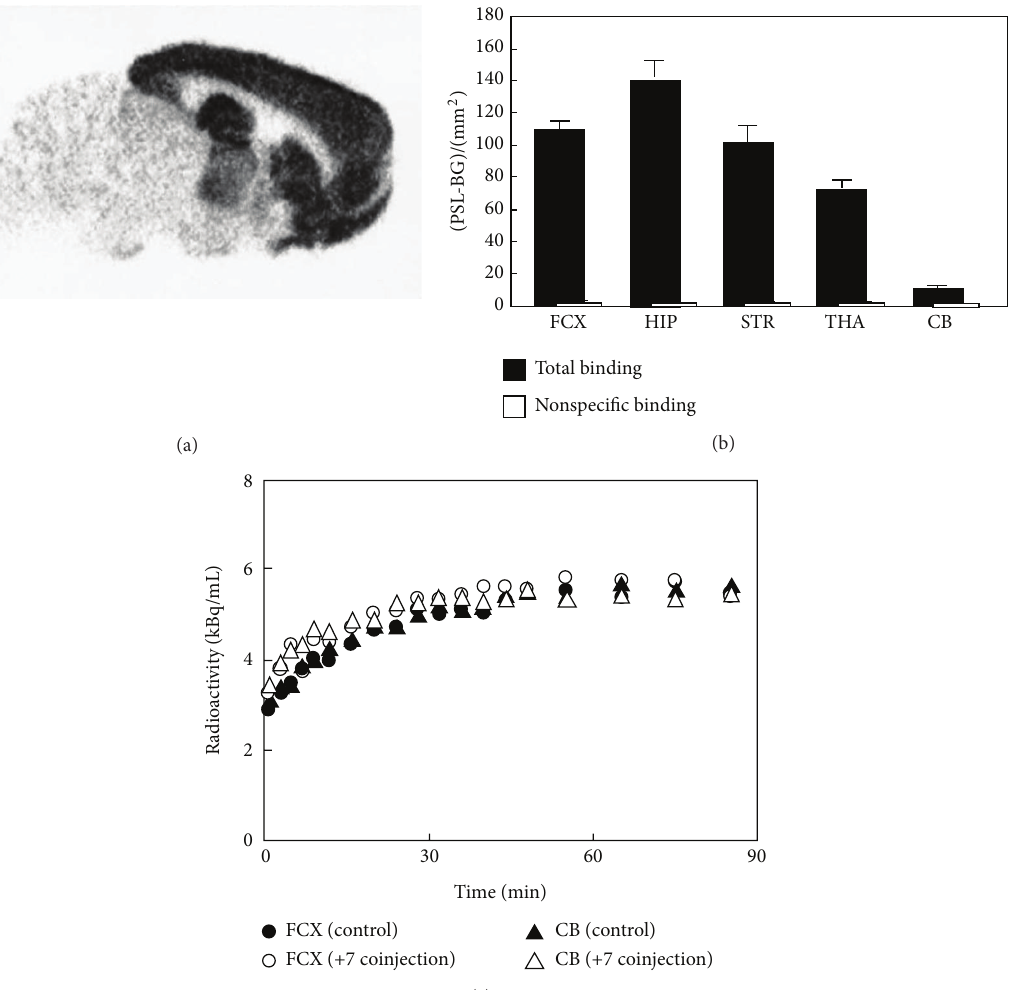
Figure 6: In vitro autoradiogram of [ 11 C] 7 (a) and quantified values of the autoradiogram in frontal cortex ( FTX ), hippocampus ( HIP ), striatum ( STR ), thalamus ( THA ), and cerebellum ( CB ) (b). Nonspecific binding was determined in the presence of (+) CP-101,606 (10 𝜇 M). (c) Time radioactivity curves in the monkey brain after administration of [ 11 C] 7 . Nonradioactive 7 (2 mg/kg) was coinjected with [ 11 C] 7 into the same monkey